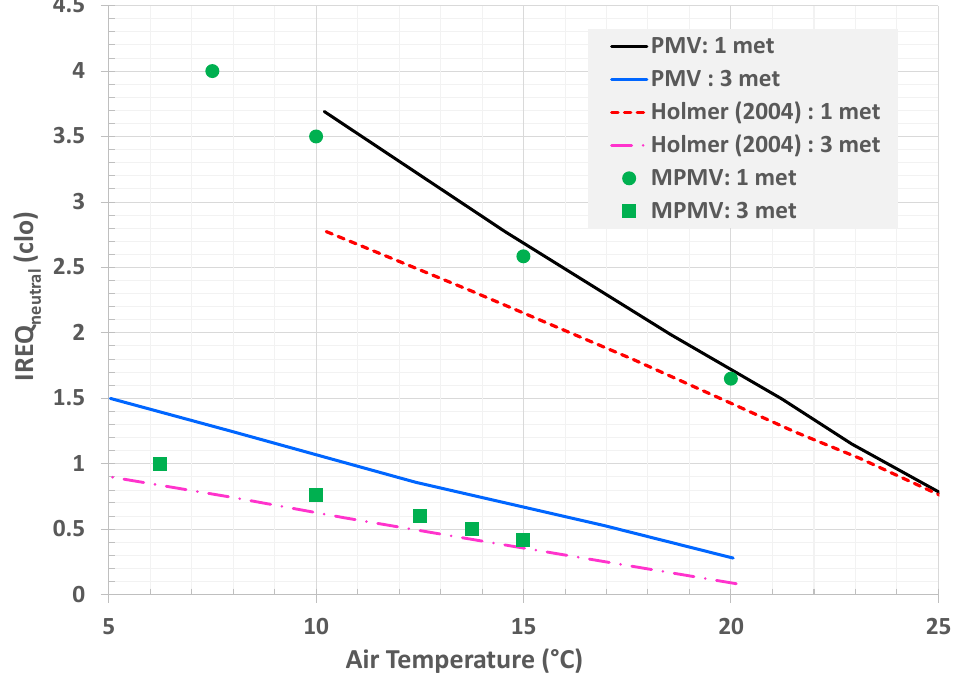
Figure 5. Required clothing insulation (IREQ neutral ) as a function of the environment temperature to achieve thermal comfort at two activity levels (1 and 3 met) for a standing and walking person in an environment with relative humidity of 50% and air speed of 0.2 m/s: Comparison with PMV and ISO/TR 11079 data as reported in Holmer [17].